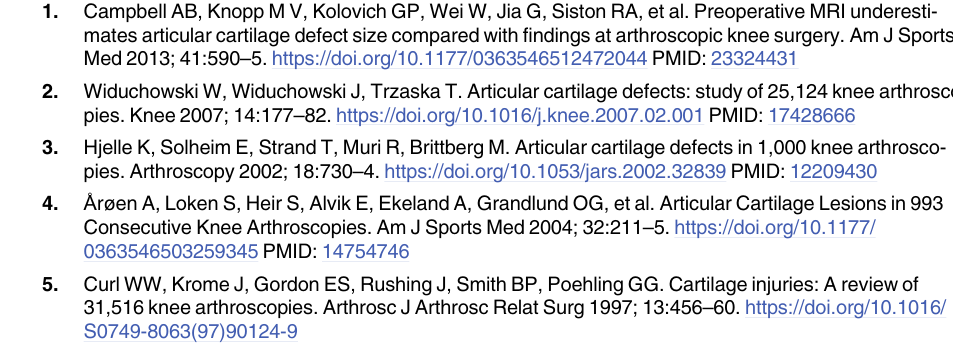
S4 Table. Raw data load distribution of defect and surrounding tissue throughout the stance phase of gait. Supporting data Fig 6. Average contact area [mm 2 ]; Contact